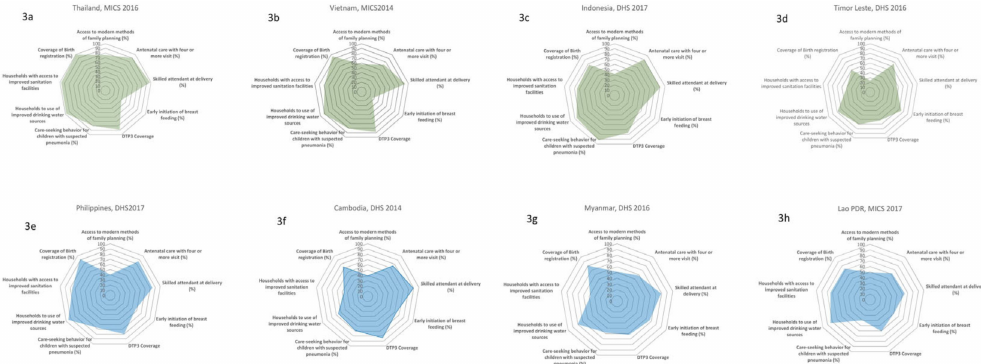
Figure 3. Achievement of women and children protection based on nine dimensions of maternal, newborn, and child health (MNCH) service coverage in eight selected countries. Data source: Thailand Multi-Indicator Cluster Survey (MICS) 2016, Viet Nam MICS 2014, Indonesia DHS 2017, Timor Leste DHS 2016, Philippines DHS 2017, Cambodia DHS 2014, Myanmar DHS 2016, and Lao PDR MICS 2017 (data from the reports of MICS and DHS in South East Asian countries [14]. ( a ) family planning (modern methods); ( b ) four quality antenatal care (ANC) visits; ( c ) skilled birth attendant rates; ( d ) the early initiation of breastfeeding; ( e ) third dose of Diphtheria-tetanus-pertussis (DTP3) immunization coverage; ( f ) care seeking for children with pneumonia; ( g ) the use of improved drinking water sources; ( h ) the use of improved sanitation; and coverage of birth